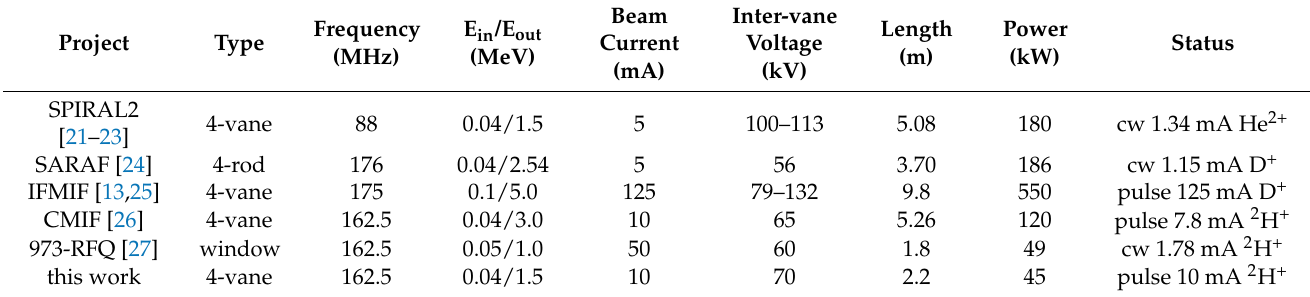
Table 2. Main parameters of the deuteron RFQs in the